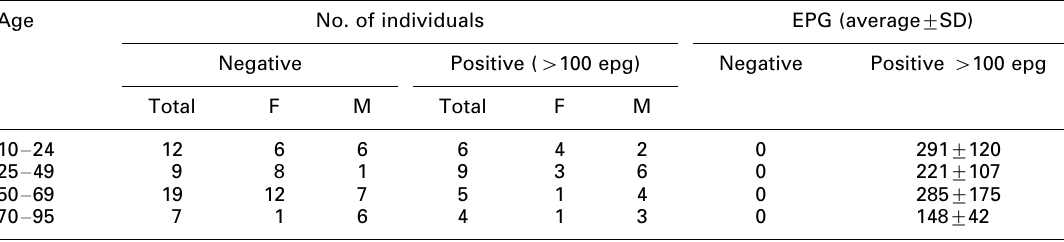
Table 1. Age and egg counts of individuals in the study sample from areas endemic for Schistosomiasis in Brazil